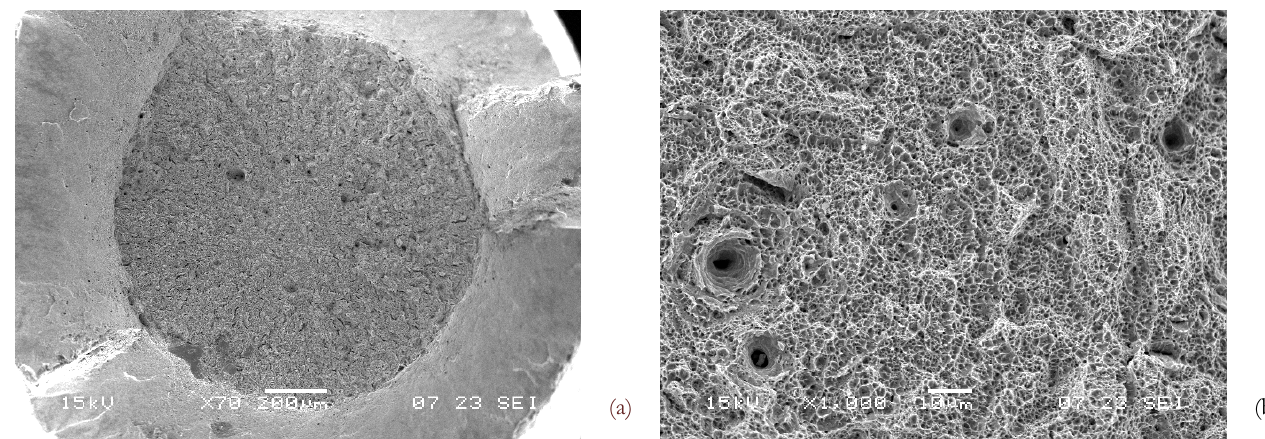
Figure 5: (a) Fracture surface for AISI 4340 specimen and (b) X1000 magnification for test in air.